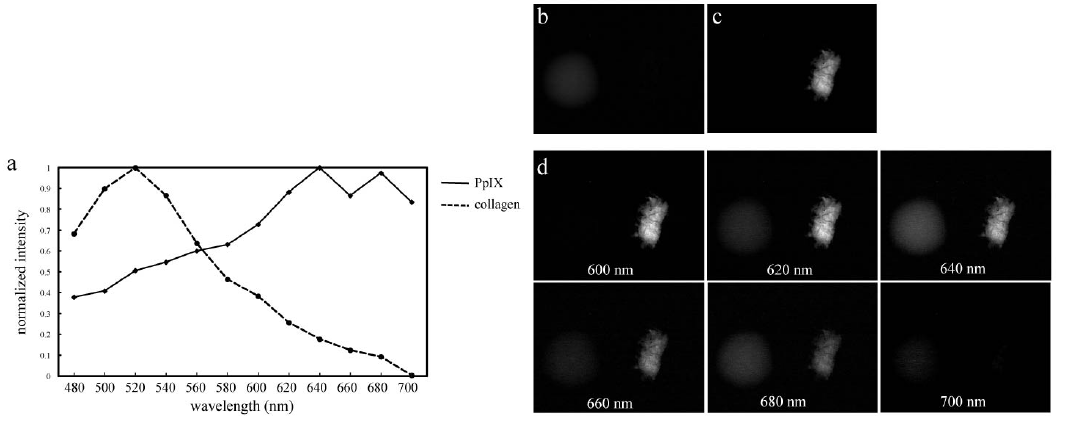
Figure 1. Spectra and spectroscopic images of protoporphyrin IX (PpIX) and collagen as references for spectral unmixing. Emission profiles of PpIX dissolved in dimethyl sulfoxide (DMSO) and of collagen powder ( a ) analyzed by the system; Acquired images of PpIX ( b ) and collagen ( c ) after spectral unmixing based on the reference spectra shown in ( a ); ( d ) Multispectral fluorescence images of PpIX (left side in each panel of ( d )) and collagen (right side in each panel of ( d )) acquired from 600 to 700 nm in 20-nm steps.